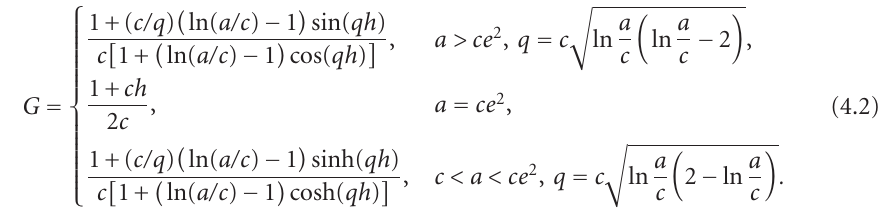
Figure 4.3 . Region of necessary and su ffi cient stability condition for (3.4): p = 12, h = 0 . 024.